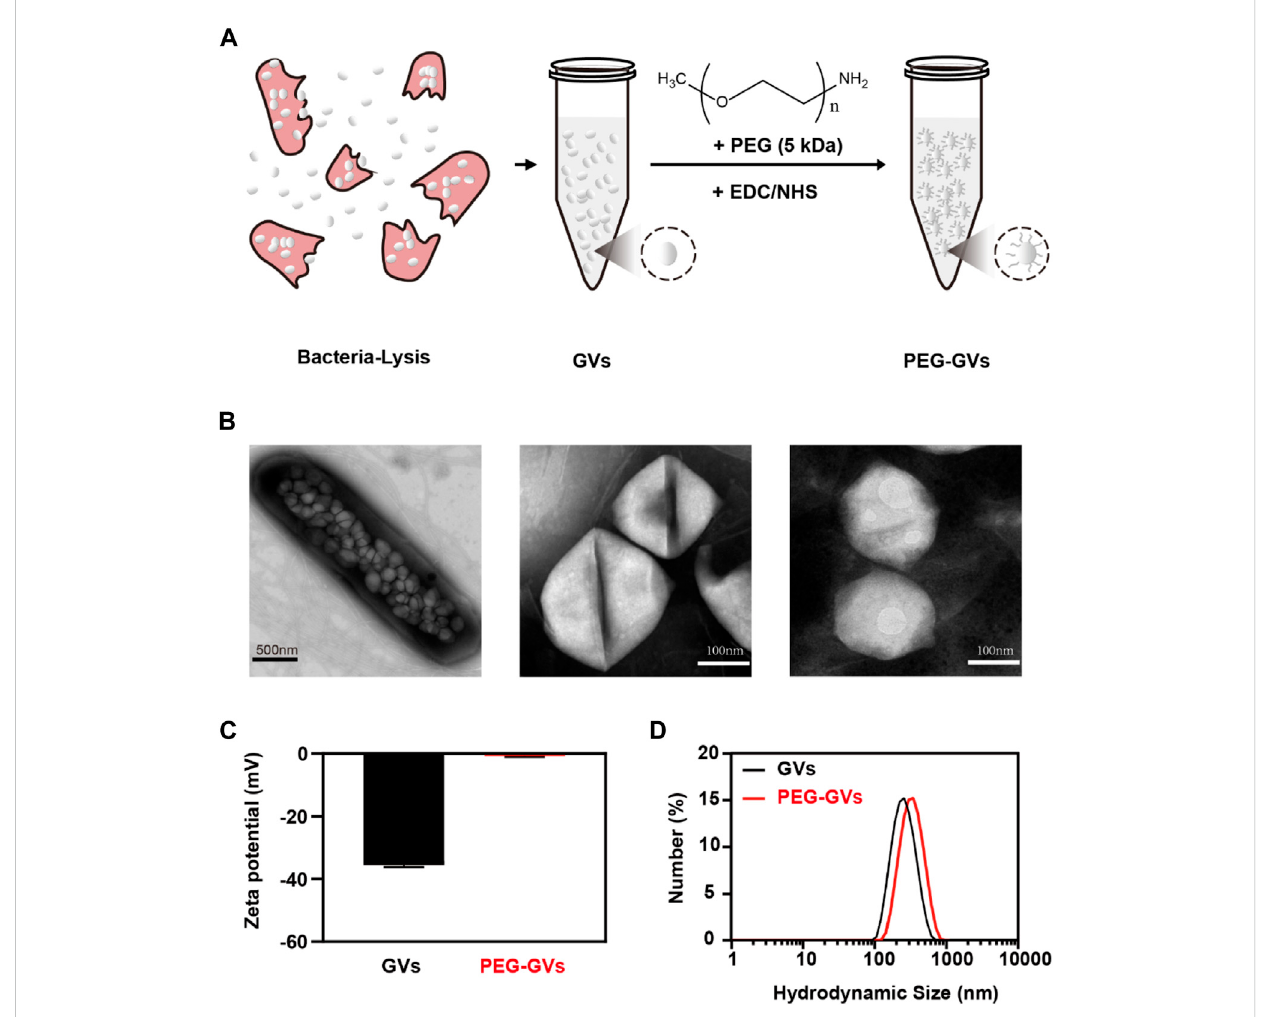
FIGURE 1 Preparation and characterization of GVs and PEG-GVs. (A) Schematic diagram of PEG-GVs preparation; (B) TEM images of Halobacterium NRC-1 (left, scalebar=500 nm),GVs(middle, scalebar= 100 nm)andPEG-GVs(right,scalebar= 100 nm); (C) ThezetapotentialofGVsandPEG-GVs; (D) The particle size distribution of GVs and PEG-GVs. Error bars represent ±